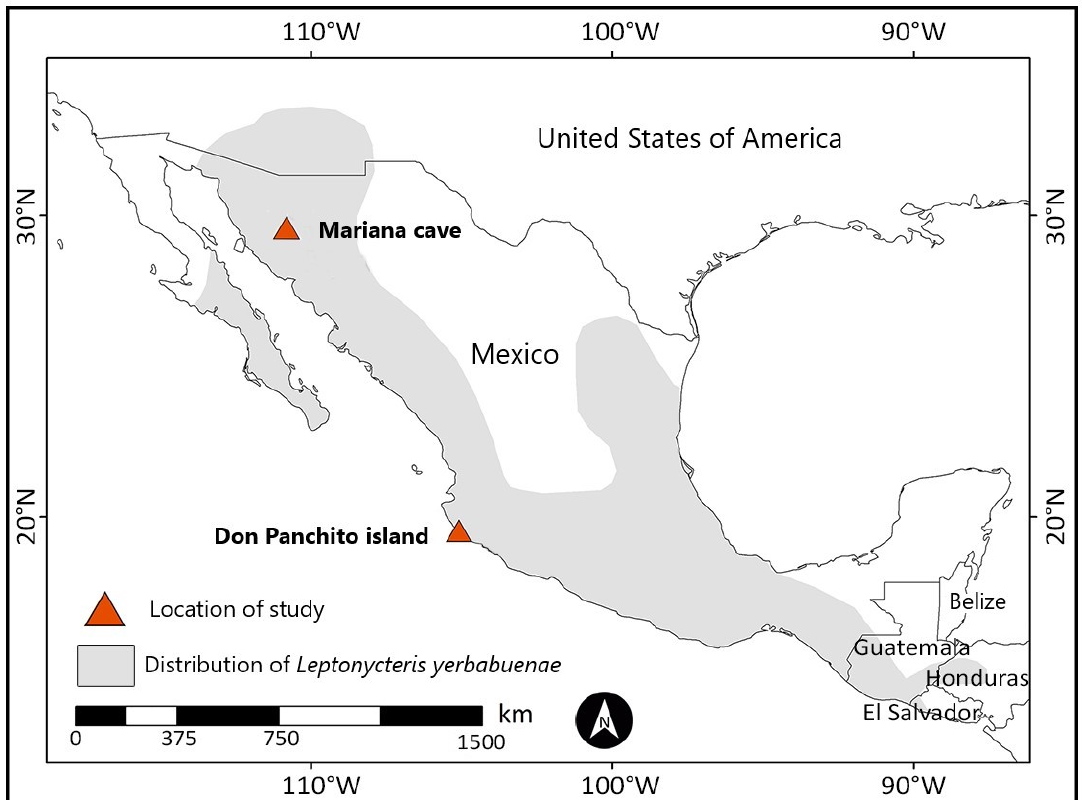
Figure 1. Geographical distribution of the lesser long-nosed bat ( Leptonycteris yerbabuenae ) [26], with sample collection sites in Mexico during 2019–2020.